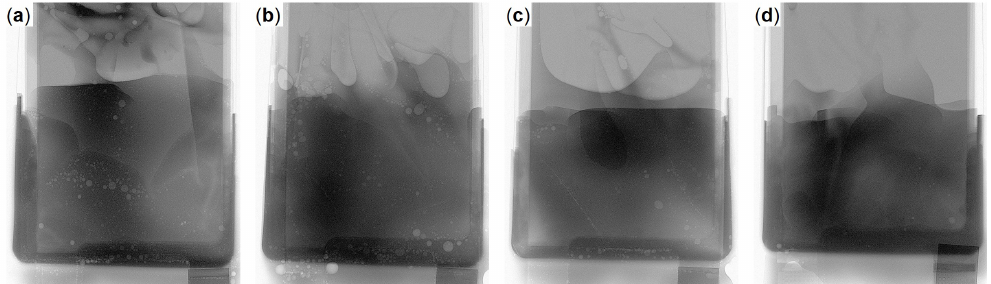
Figure 9. X-ray image of LIBs during filling of 10mL contrast agent after 60 s. ( a ): 200mbar absolute pressure; ( b ): 400 mbar absolute pressure; ( c ): 600 mbar absolute pressure; ( d ): 800 mbar absolute